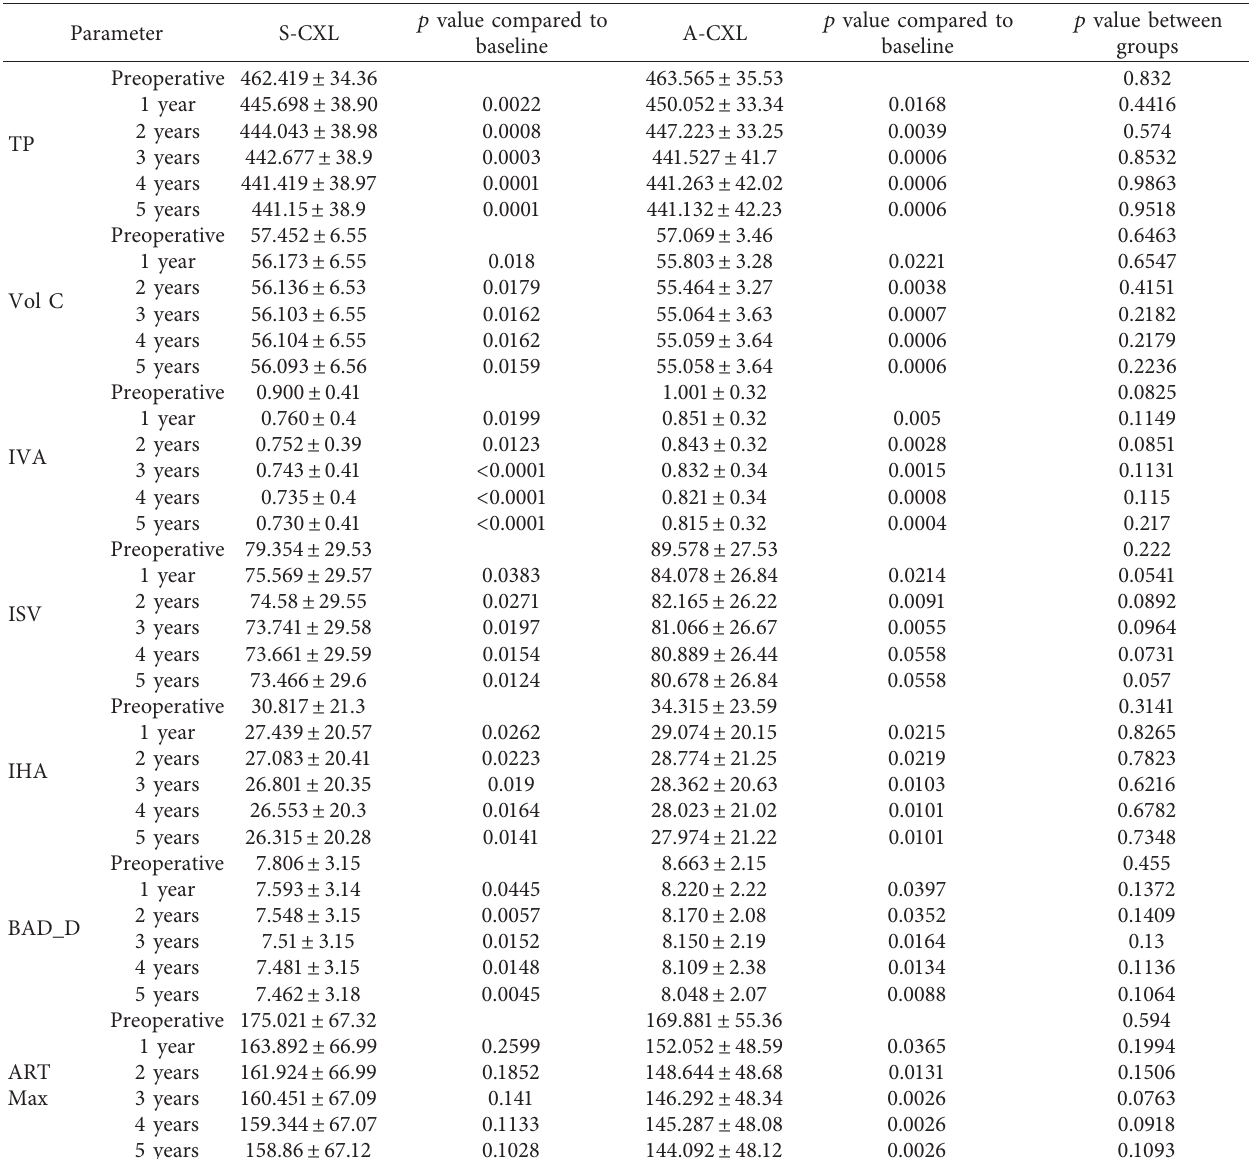
Table 3: Topographical parameter evolution in both